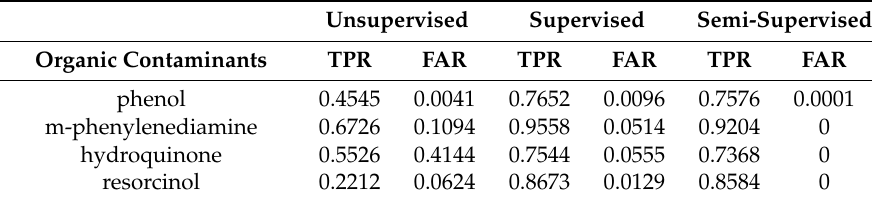
Table 3. Comparison of three methods based on the points’ level.